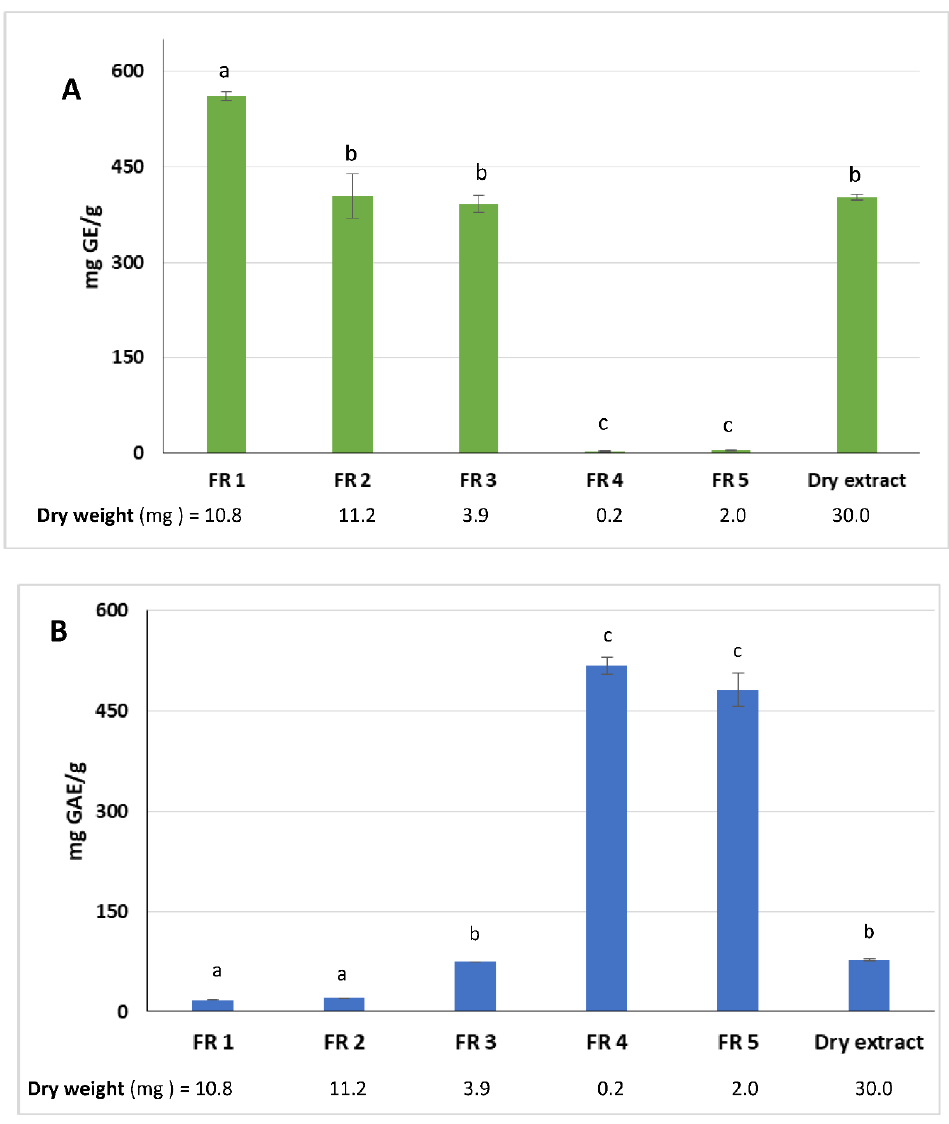
Figure 2. Total reducing sugars ( A ) and phenolic content ( B ) in the fractions obtained by C18 separation of 30 mg of “Greco” grape cane dry extract (pH 7, 60 min). GE = Glucose Equivalents; FR = fraction; GAE = Gallic Acid Equivalents. All determinations were performed in triplicate and results were expressed as mean ± SD. Bars with different letters denote significant differences at p < 0.05. The highest amount of polyphenols was detected in FR 4 and FR 5 with 517.4 ± 17.4 and 481.2 ± 36.7 mg GAE/g fraction, respectively (Figure 2B). Differences among the phe- nolic content of FR 4 and FR 5 with the other fractions and the dry extract were very sig- nificant ( p < 0.0001). The phenolic compounds were highly concentrated in the two frac- tions and represented 60% of the total polyphenols recovered.